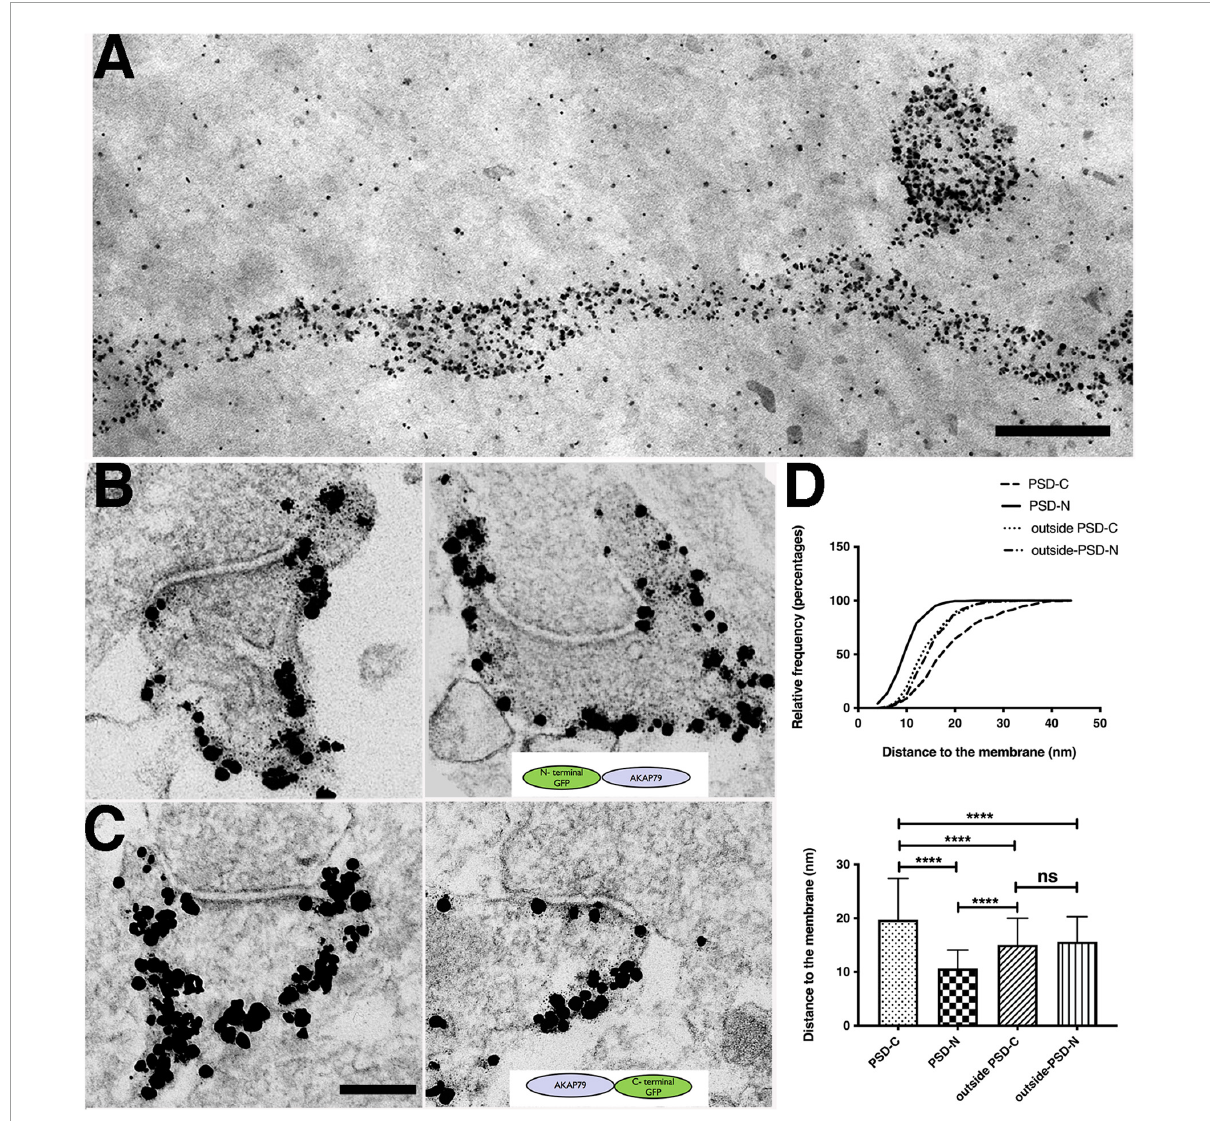
FIGURE4 Molecular configuration of AKAP79 at spine synapses determined by immunogold EM. (A) Thick section STEM image of immunogold labels of overexpressed AKAP79-GFP (with anti-GFP antibody) showing extensive AKAP79 labels at the dendritic and spine membrane. Scale bar 400 nm. Non-specific gold particles are added as 10 nm fiducial markers for aiding tomography reconstructions. (B) Immunogold labeling of GFP in N-terminally tagged GFP-AKAP79 at synapses (C) Immunogold labeling of GFP in C-terminally tagged AKAP-GFP. Scale bar 200 nm. (D) Cumulative distribution (top) and histogram (bottom) comparing localization of N-terminally tagged GFP-AKAP79 in the PSD (PSD-N) and outside the PSD at the extra-synaptic membrane (outside-PSD-N) vs. C-terminally tagged AKAP79-GFP in the PSD (PSD-C) and outside the PSD at the extra-synaptic membrane (outside-PSD-C). **** p < 0.0001, ns p >